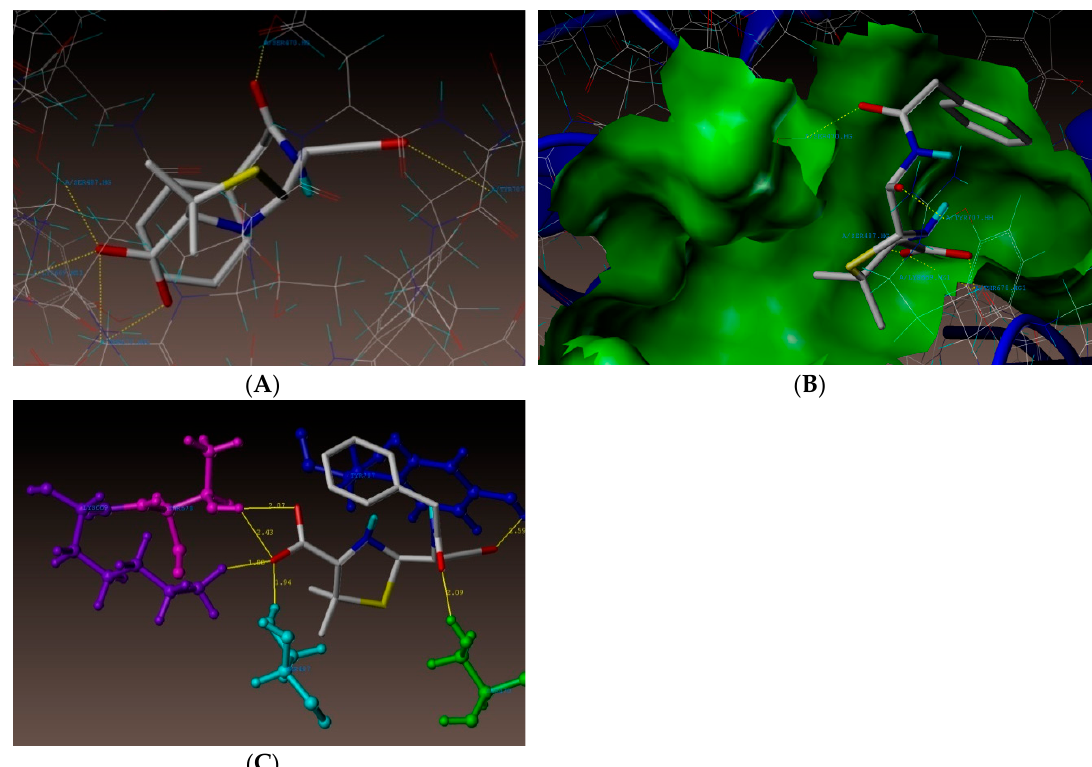
Figure 4. ( A ) Docked view of compound 3j . ( B ) Docked view of compound 3j at the active site of enzyme PDB ID: 3UDI. ( C ) Hydrogen-bond interaction of compound 3j at the active site.